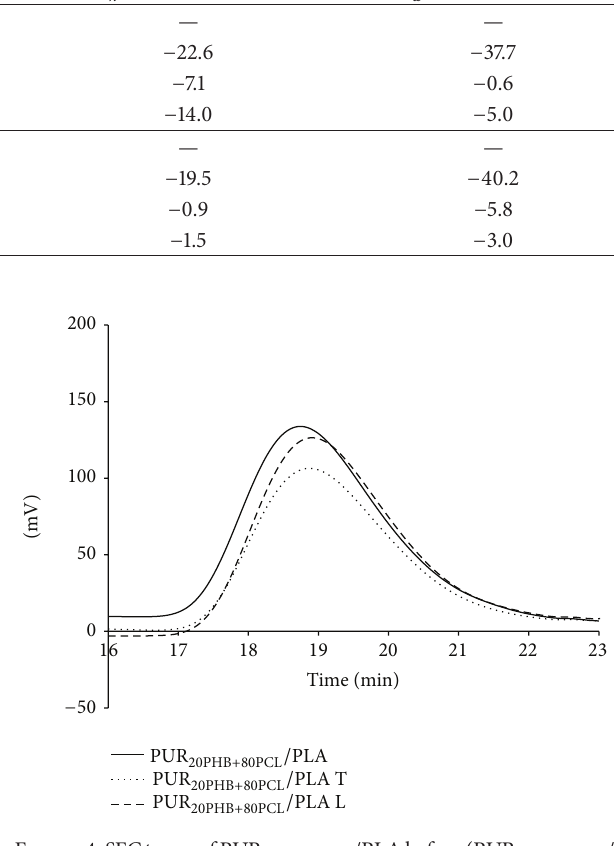
Figure 4: SECtraces of PUR 20PHB + 80PCL /PLA before (PUR 20PHB + 80PCL / PLA) and after incubation in trypsin (PUR 20PHB + 80PCL /PLA T) and in lipase (PUR 20PHB + 80PCL /PLA